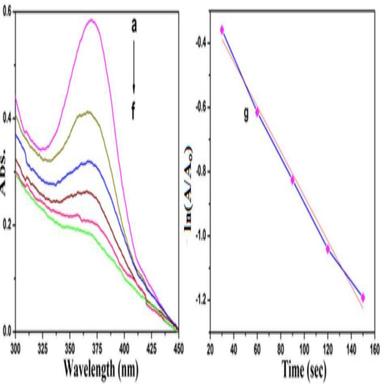
UV–visible spectrum of PDC taken at 30 s time interval in the presence of Cu-TCPFOSi hierarchical structured catalyst and NaBH4 (a–f) and plot of time against ln(A/Ao) (g).